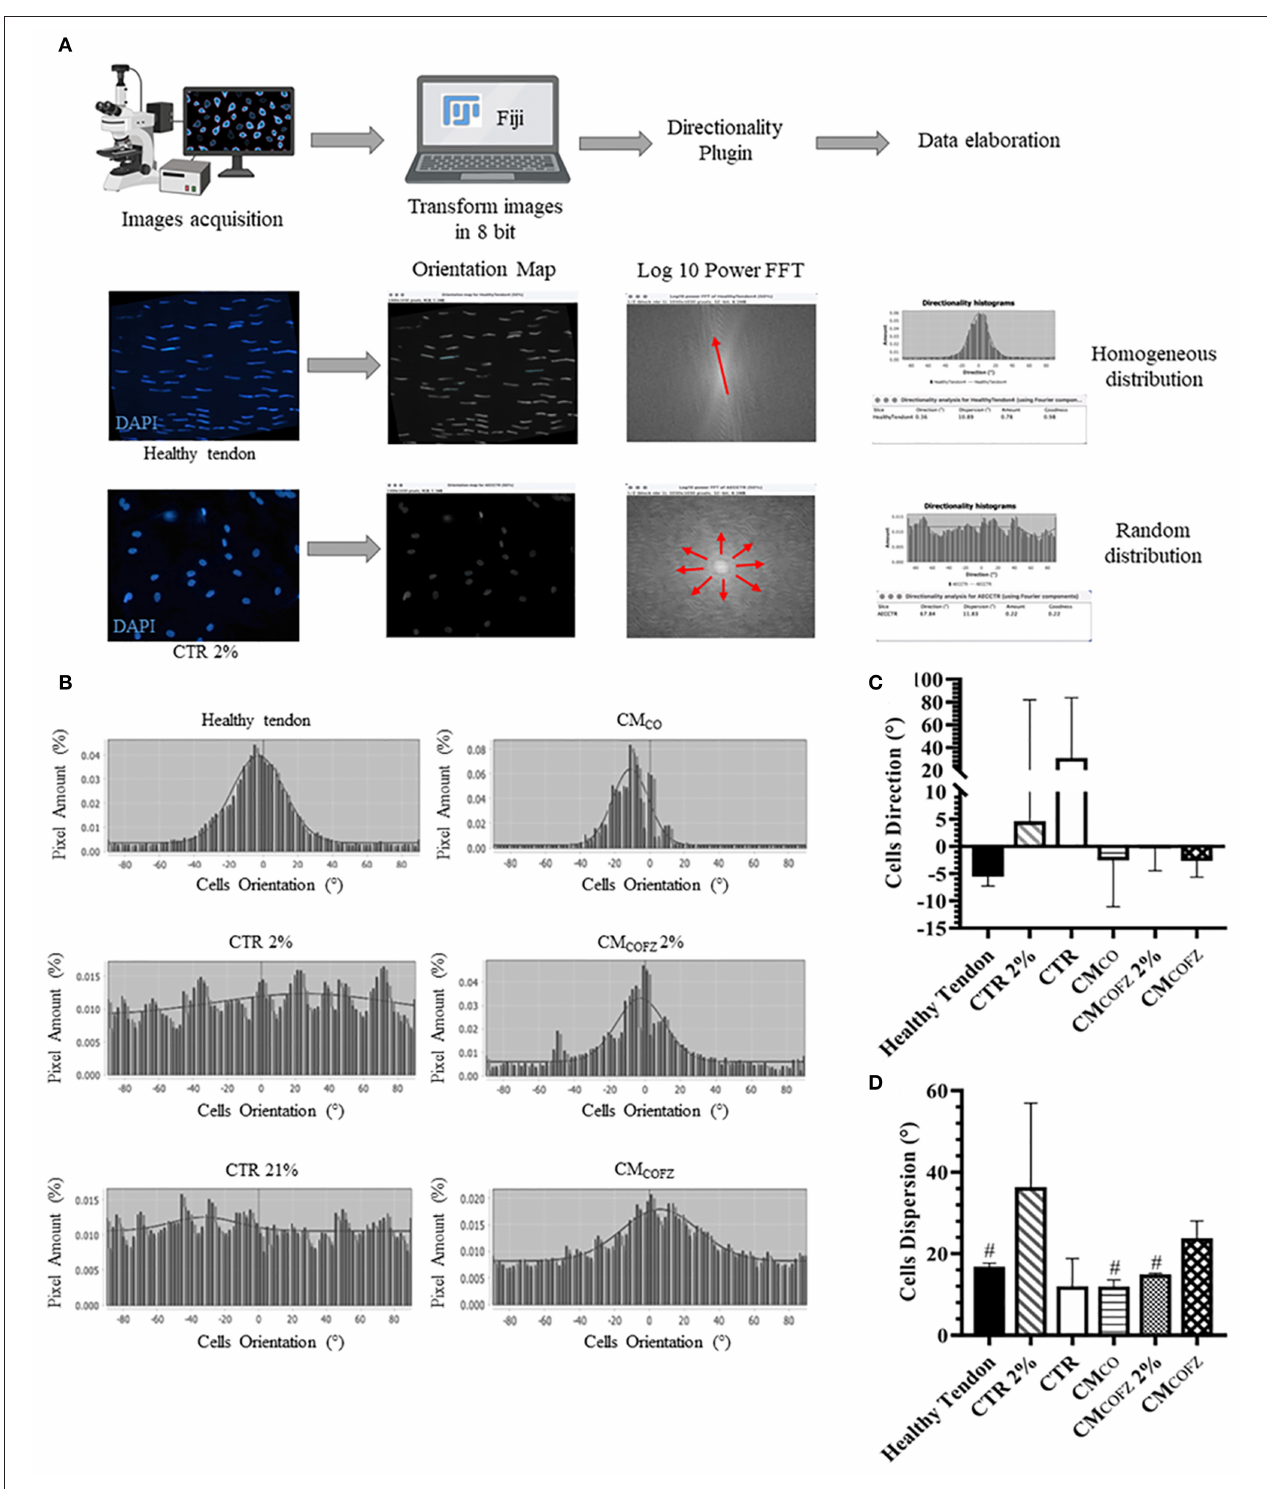
FIGURE 8 | Directionality analyses on AECs cells orientation in 3D tendon-like structures under different culture conditions. (A) Representative scheme of the Directionality Plugin used to analyse cells orientation within the different treated groups. (B) Representative Gaussian graphs [X = Cells Orientation ( ◦ ), Y = Pixel Amount (%)]. Analysis of (C) angle direction (cells orientation calculated on the bases of the longitudinal axis of the sample) and (D) angle dispersion (the standard deviation of the Gaussian). Healthy tendon was used as reference sample for the analyses. Statistical analyses were performed by One Way ANOVA and expressed as means ± S.D of six biological replicates ( n = 6 animals) for each experimental condition performed in triplicate. Values were considered significant for p < 0.05, with the indicated superscript # vs. CM COFZ .